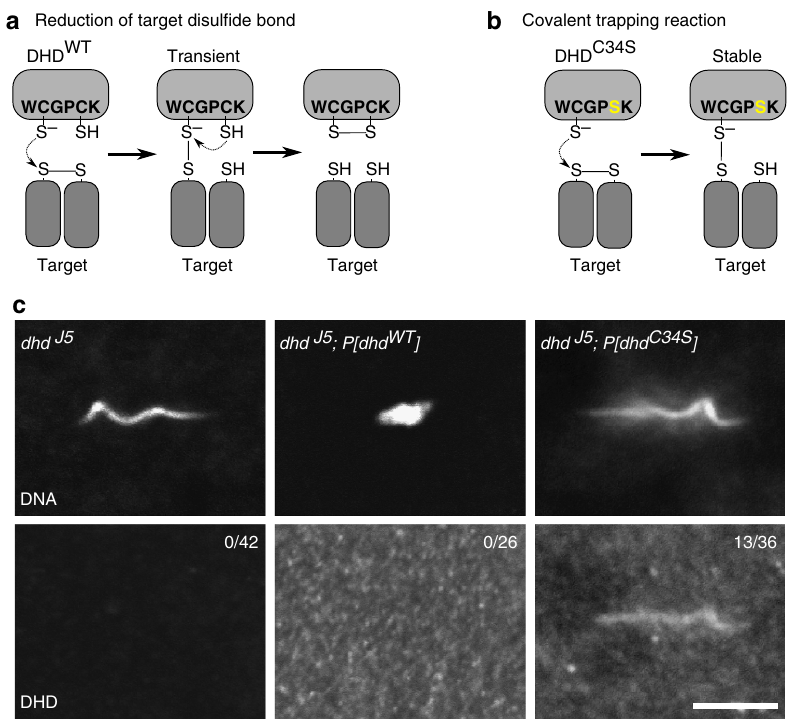
Figure 6 | DHD is specifically targeted to the sperm nucleus at fertilization. ( a ) Mechanism of disulfide bond reduction on target proteins by wild-type DHD. ( b ) Strategy for trapping DHD on its targets: the replacement of the resolving cysteine with a serine (C34S) in the WCGPCK motif is predicted to stabilize the mixed-disulfide between DHD and its target. ( c ) Sperm nuclei in eggs laid by females of the indicated genotypes stained for DNA and with the anti-DHD antibody. The number of DHD-positive sperm nuclei is indicated for each genotype. See also Supplementary Fig. 8. Scale bar, 5 m